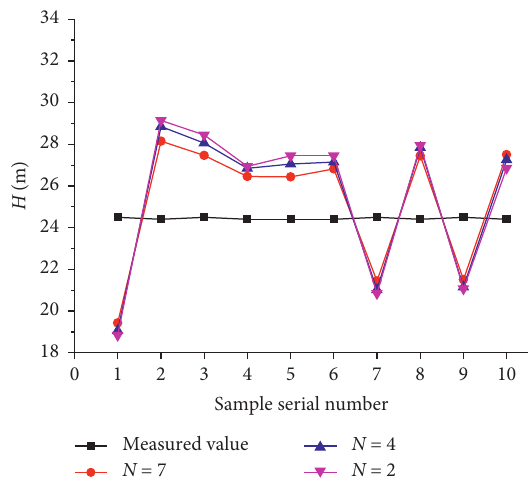
Figure 10: The prediction curve of H when the number of BP neural network neurons was 2, 4, and 7, respectively.